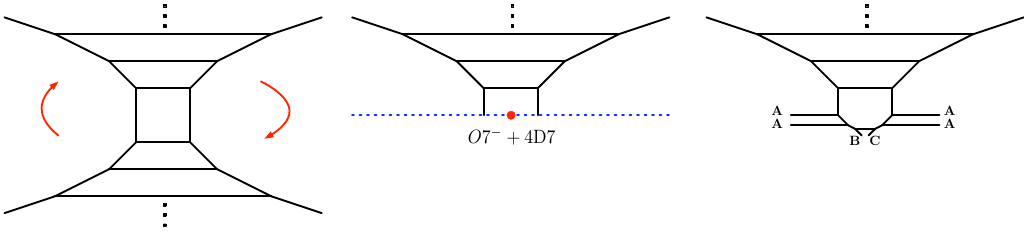
Figure 7 . The Z 2 quotient and the insertion of an O7 − -plane and four D7-branes at the center of a 180 degree rotation. Equivalently one can insert A 4 BC